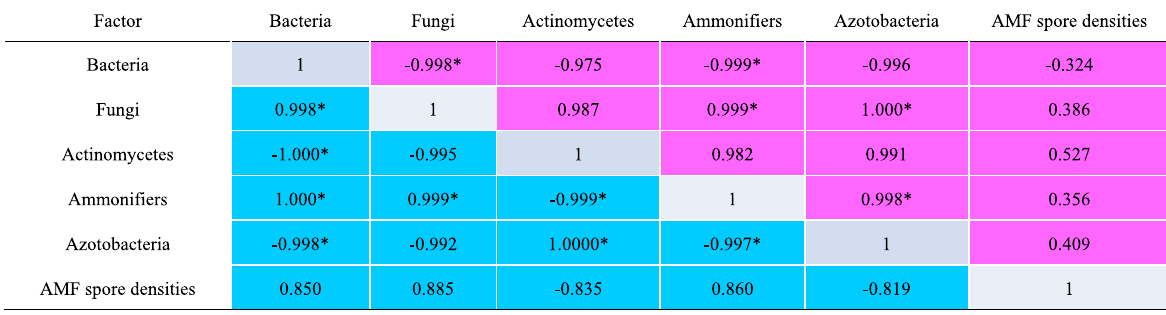
Values were presented in table as the Pearson’s correlation coefficient, n 3. Bivariate correlation analysis was performed in correlation analysis = * and ** indicate significant difference at 0.05 and 0.01 level of probabilities in correlations between rhizosphere soil microbial populations of RW and